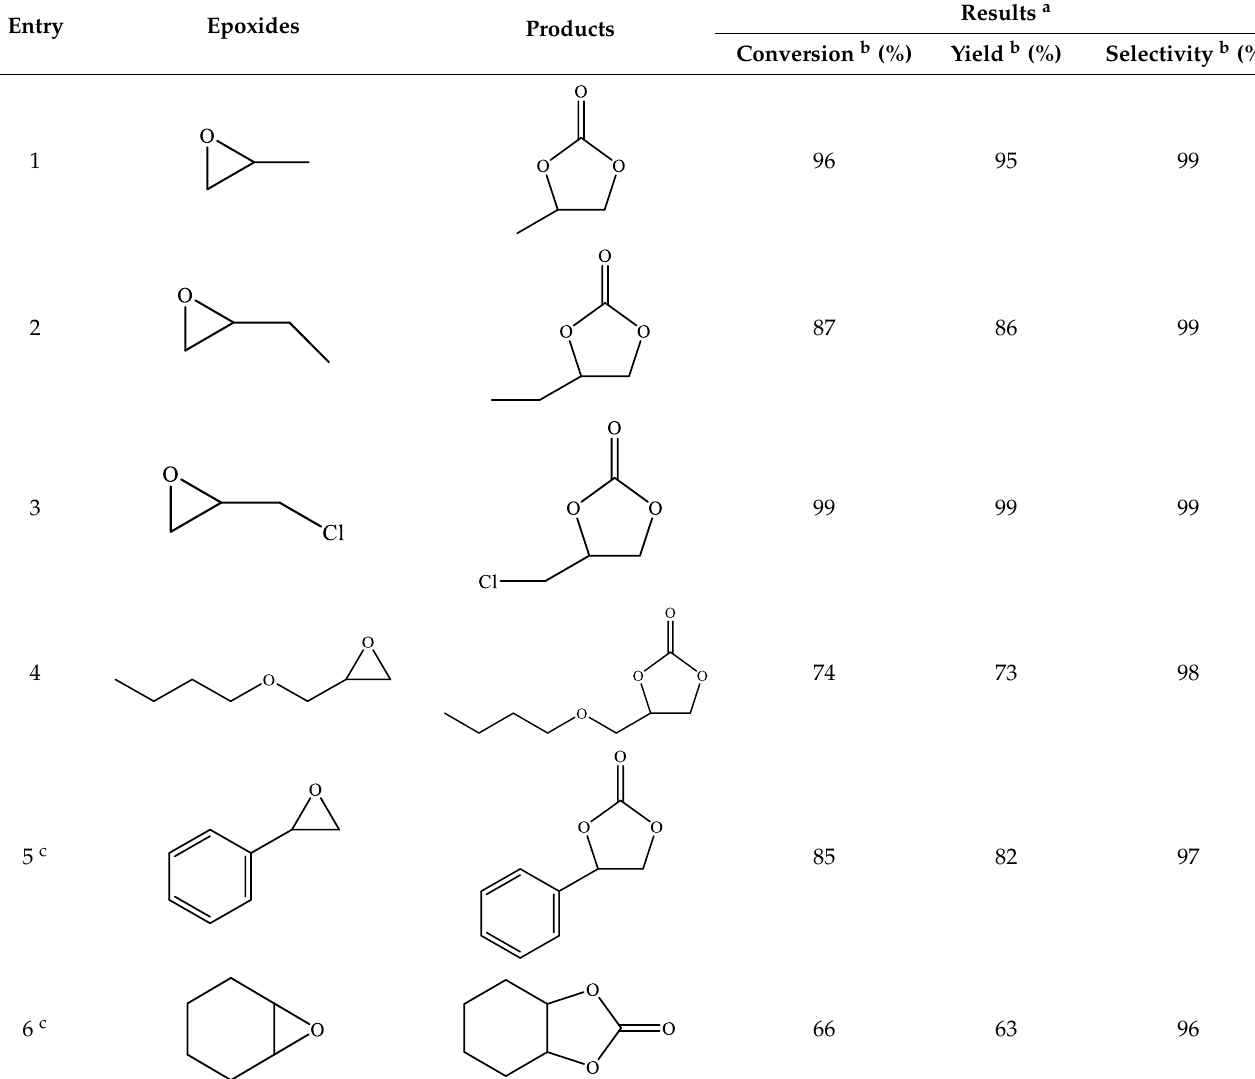
Table 3. Universality of BP-CN-1 for catalytic conversion of various epoxides a . Entry Epoxides